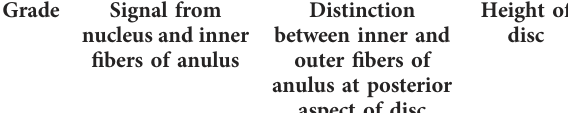
TABLE 1 Modi fi ed p fi rrmann grade of disc degeneration